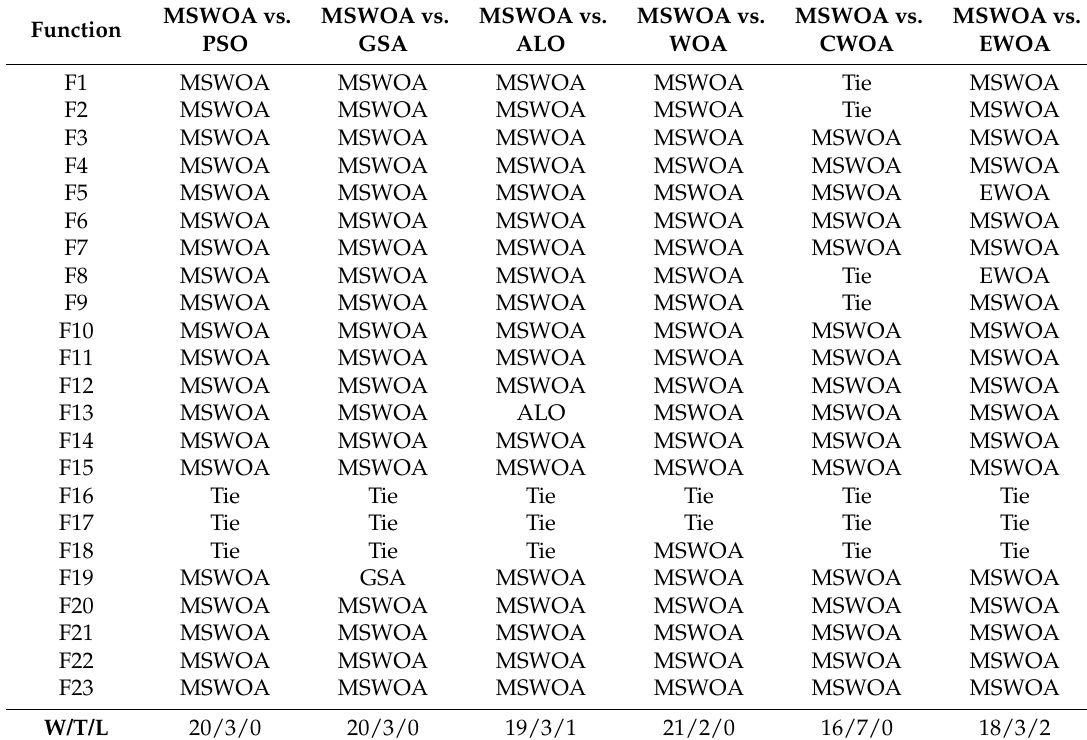
Table 7. The Wilcoxon signed-rank single-problem test for statistically significance level at alfa = 0.05. MSWOA Function